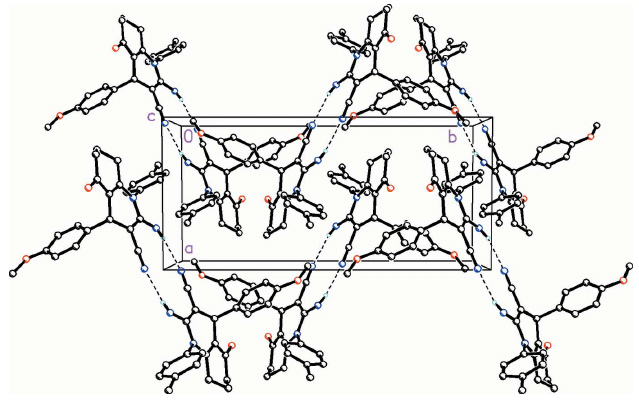
Figure 2 The molecular packing, viewed along the c axis, showing the inter- molecular hydrogen bonds as dashed lines.